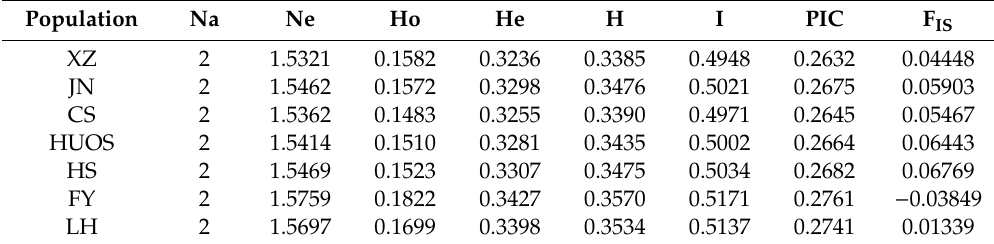
Table 3. Genetic diversity of seven Chinese elm populations.